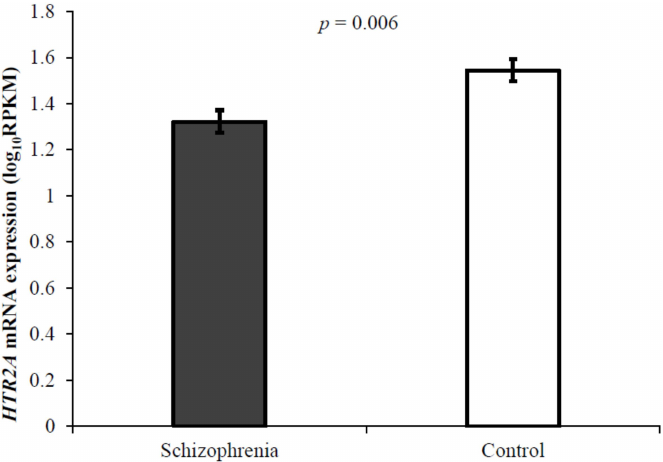
Figure 2. HTR2A mRNA expression in patients with schizophrenia compared to controls. ANOVA showing mean expression level and standard error in patients with schizophrenia.